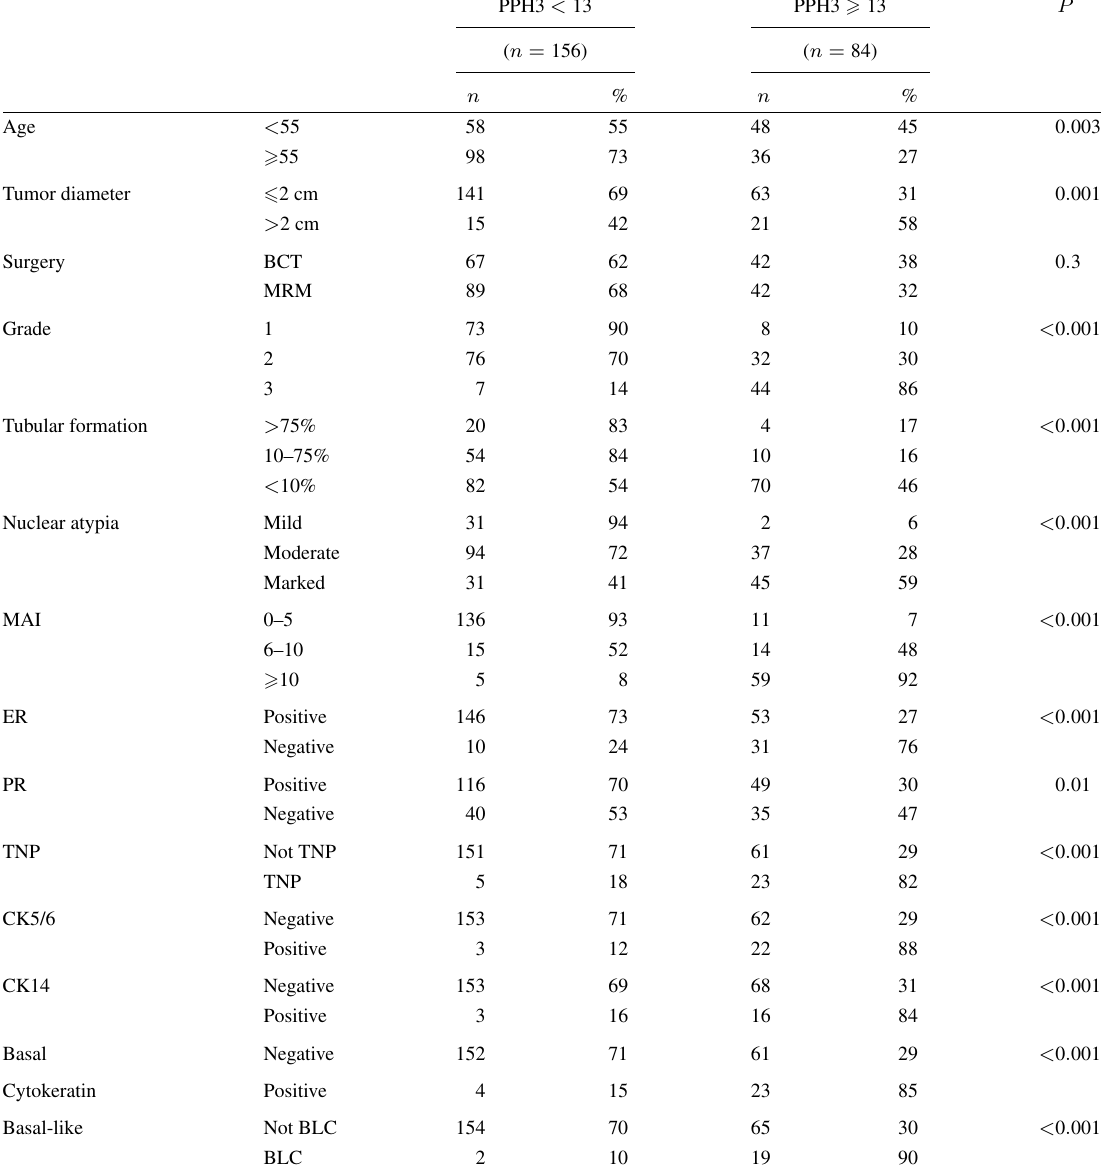
Correlation of the PPH3 index and clinico-pathologic